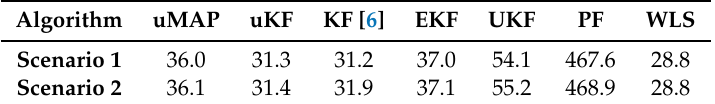
Running time (s) of the considered algorithms for M c